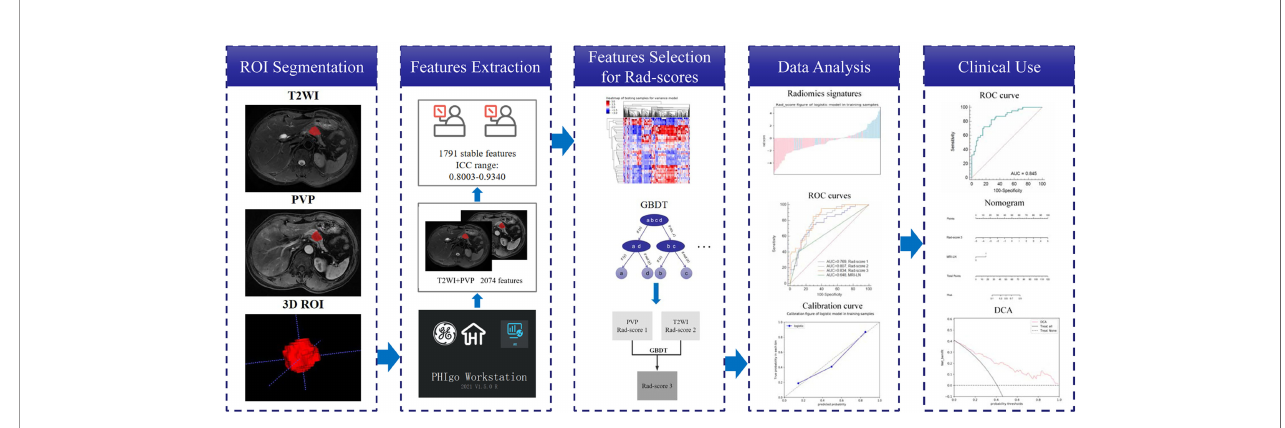
FIGURE 2 | Radiomics and model construction work fl ow.